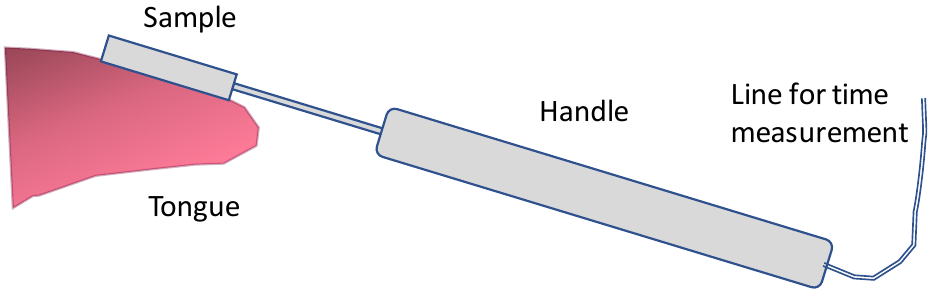
Figure 4. Application of the measuring spoon conducting a test.